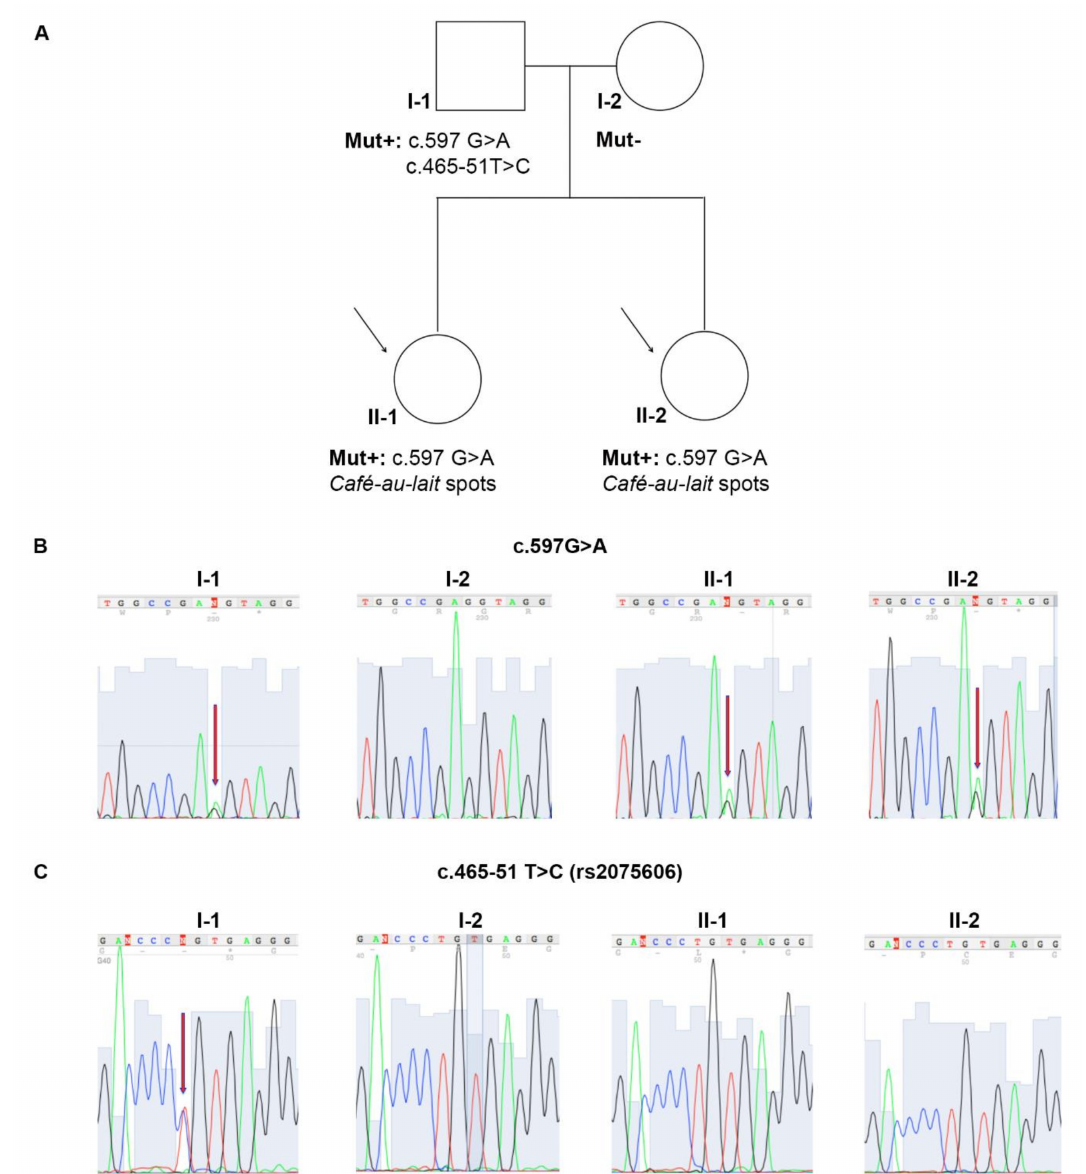
Figure 2. Molecular analysis of STK11 / LKB1 gene. ( A ) Pedigree of the Peutz–Jeghers Syndrome (PJS) suspected family. ( B ) Electropherograms of STK11 sequence analysis showing the c.597G → A substitution in the exon 4. ( C ) Electropherograms of STK11 sequence analysis showing the c.465-51 T → C single-nucleotide polymorphism (SNP) in the intron 4. Red arrows indicate nucleotide changes; black arrows indicate the two PJS